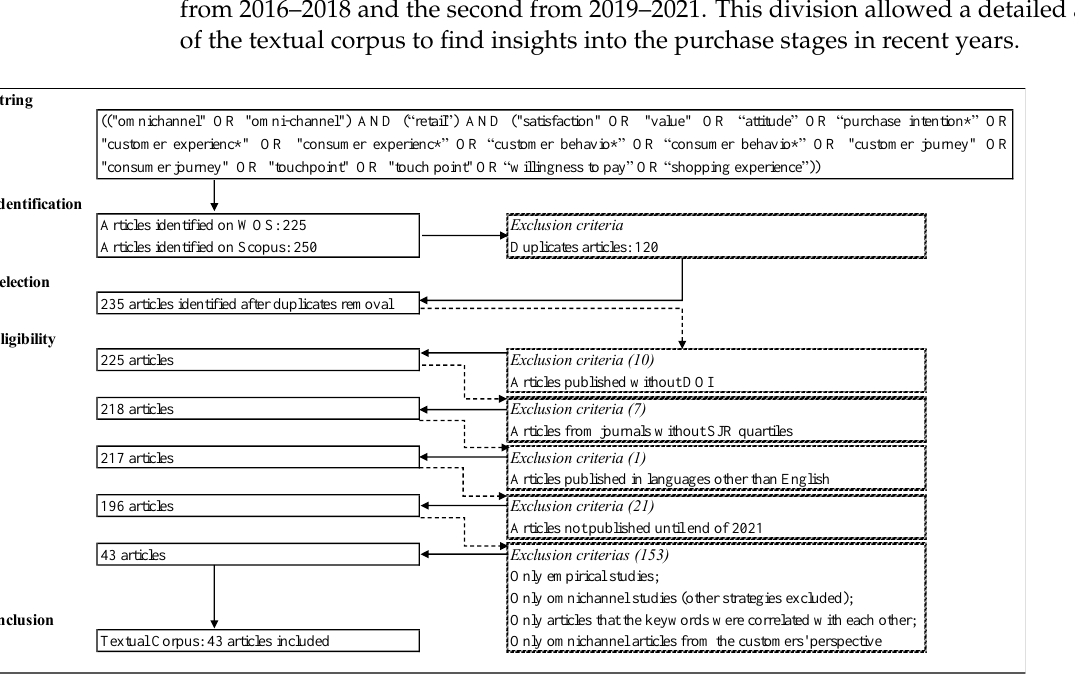
Figure 1. Results obtained in the arranging stage.